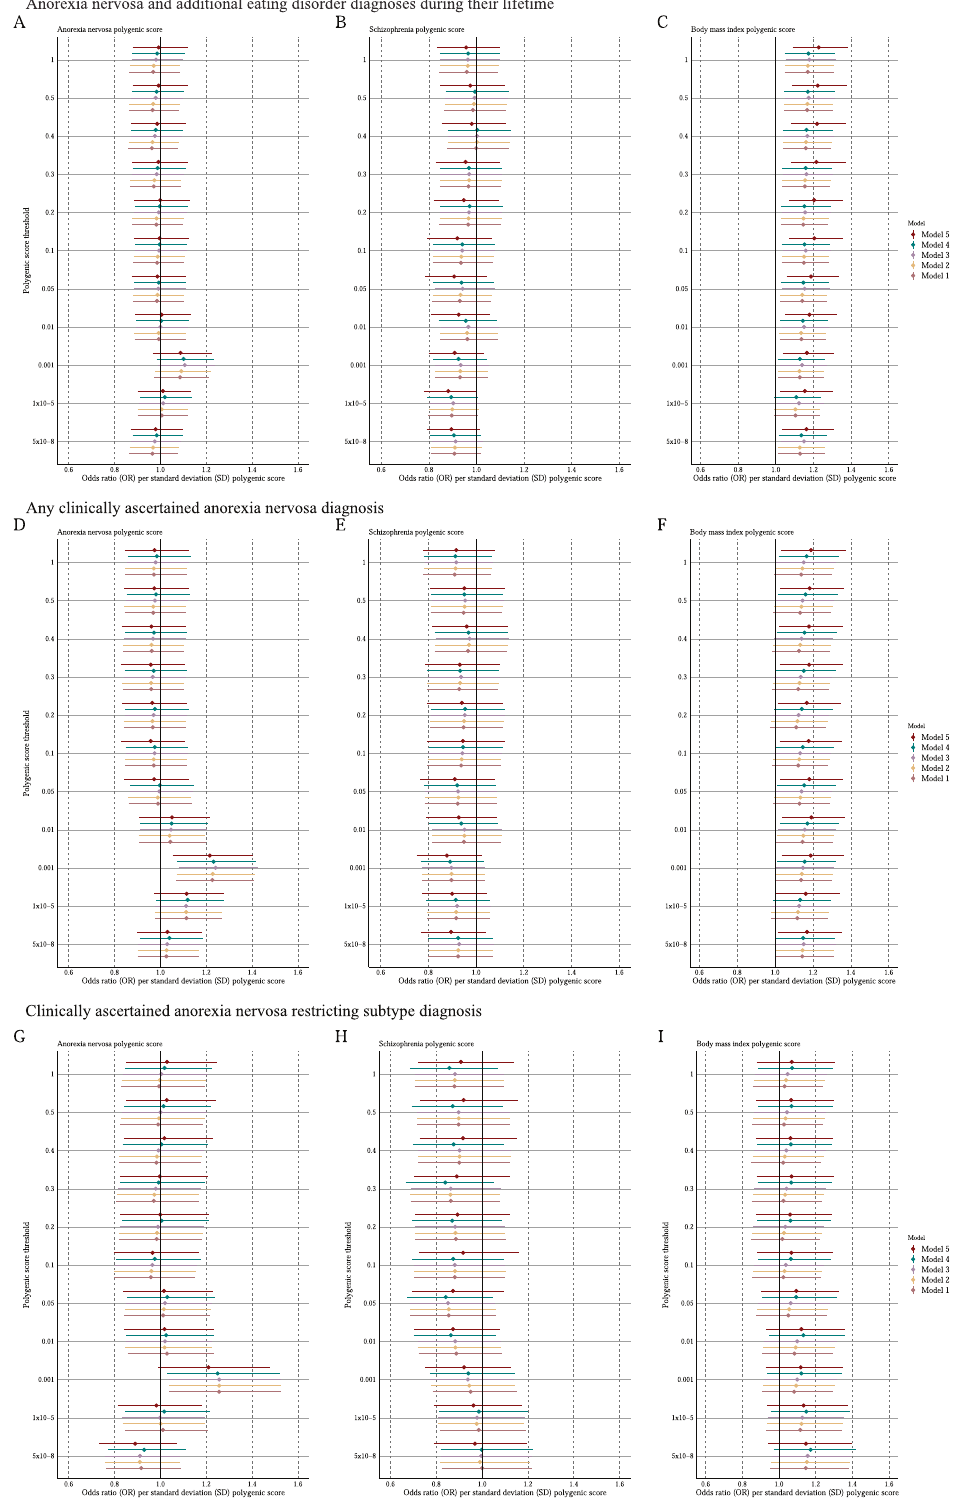
Fig. 4 Polygenic scores (PGSs) associated with a severe and enduring eating disorder (SEED). A – C 1334 individuals with anorexia nervosa and additional eating disorder diagnoses during their lifetime ( n SEED = 528, n non-SEED = 806). Figure 4A shows the association with the anorexia nervosa PGS, Fig. 4B with the schizophrenia PGS, and Fig. 4C with the BMI PGS. D – F 901 individuals with any clinical anorexia nervosa diagnosis ( n SEED = 337, n non-SEED = 564). D shows the association with the anorexia nervosa PGS, E with the schizophrenia PGS, and F with the BMI PGS. G – I 509 individuals with a clinical anorexia nervosa restricting subtype diagnosis ( n SEED = 178, n non-SEED = 331). G shows the association with the anorexia nervosa PGS, H with schizophrenia PGS, and I with the BMI PGS. The estimates in model 3 are adjusted for covariates included in the main model: Principal components 1 – 10, treatment region, age, sex and eating disorder diagnosis when including individuals with any eating disorder diagnosis. Dots represent odds ratios (ORs) and error bars 95% con fi dence intervals. Translational Psychiatry (2022)